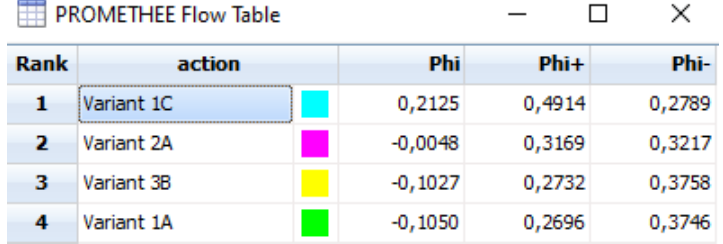
Figure 6. An overview of the result of scenario 2 of the multi-criteria analysis of the evaluation of the Rijeka—Zagreb route section.